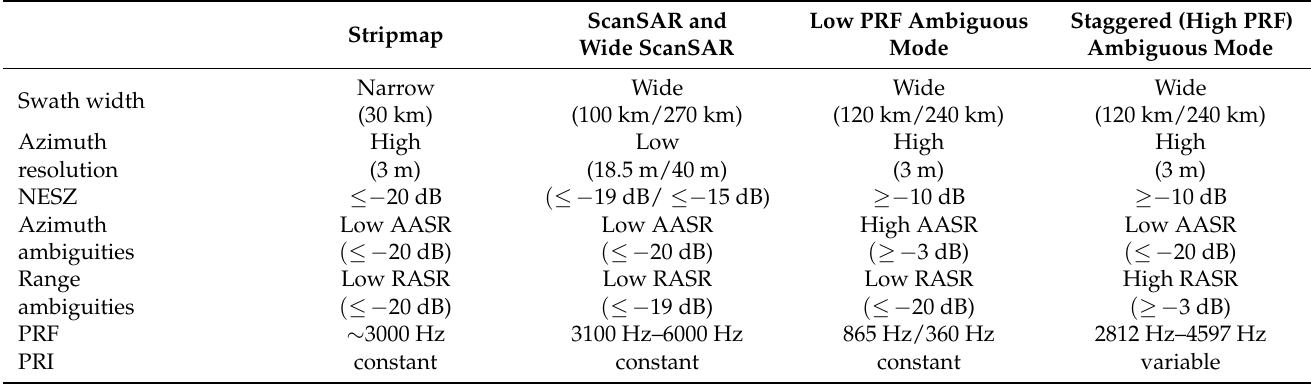
Table 1. Comparison of the low PRF ambiguous mode and staggered (high PRF) ambiguous mode with the stripmap mode and ScanSAR/Wide ScanSAR mode of